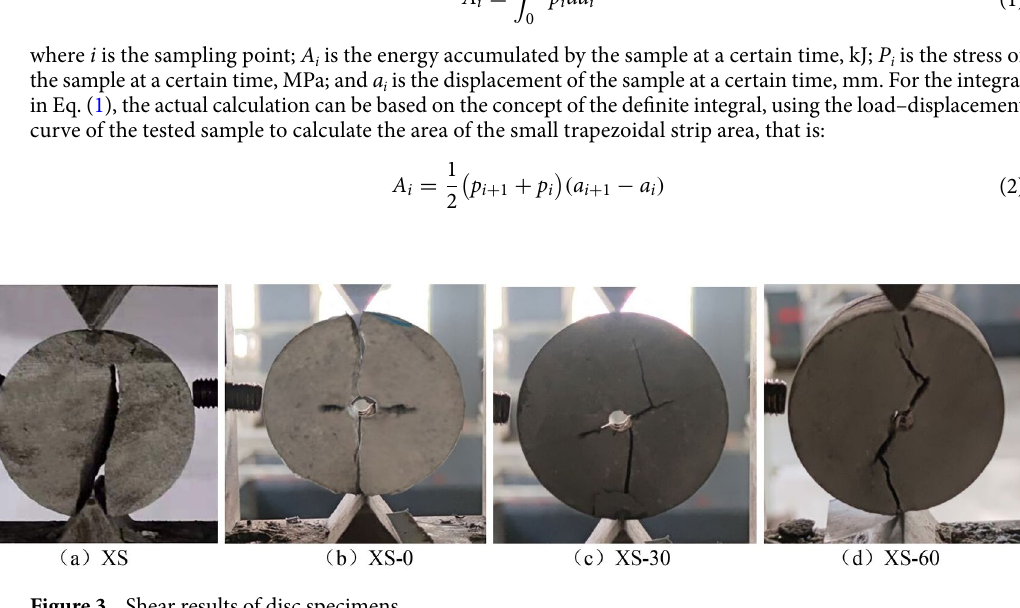
Figure 3. Shear results of disc specimens.